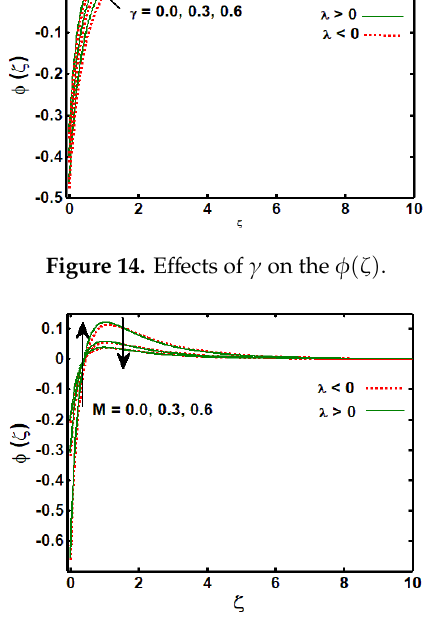
Figure 15. E ff ects of M on the φ ( ζ ) Figure 15. Effects of 𝑴 on the 𝝓(𝜻) . Figure 15. Effects of 𝑴 on the 𝝓(𝜻) . Figure 15. Effects of 𝑴 on the 𝝓(𝜻) . Figure 15. Effects of 𝑴 on the 𝝓(𝜻) .